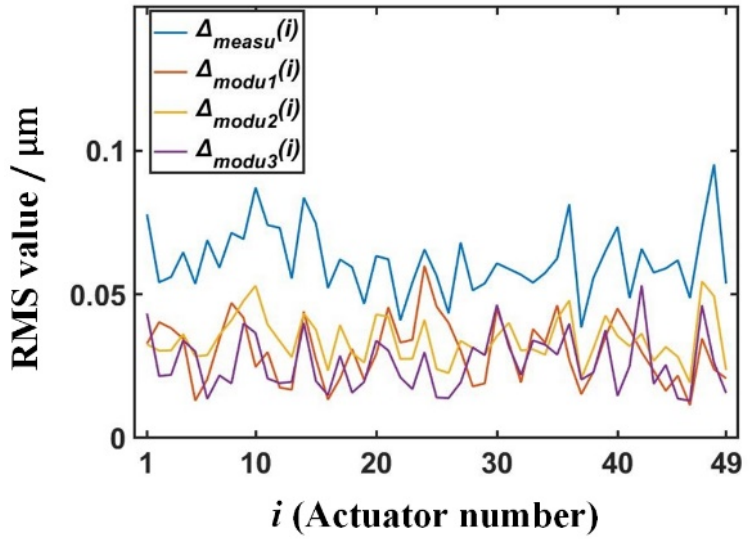
Figure 7. RMS values of the IF deviation ∆ measu ( i ) , ∆ modu 1 ( i ) , ∆ modu 2 ( i ) and ∆ modu 3 ( i ) for each actuator.